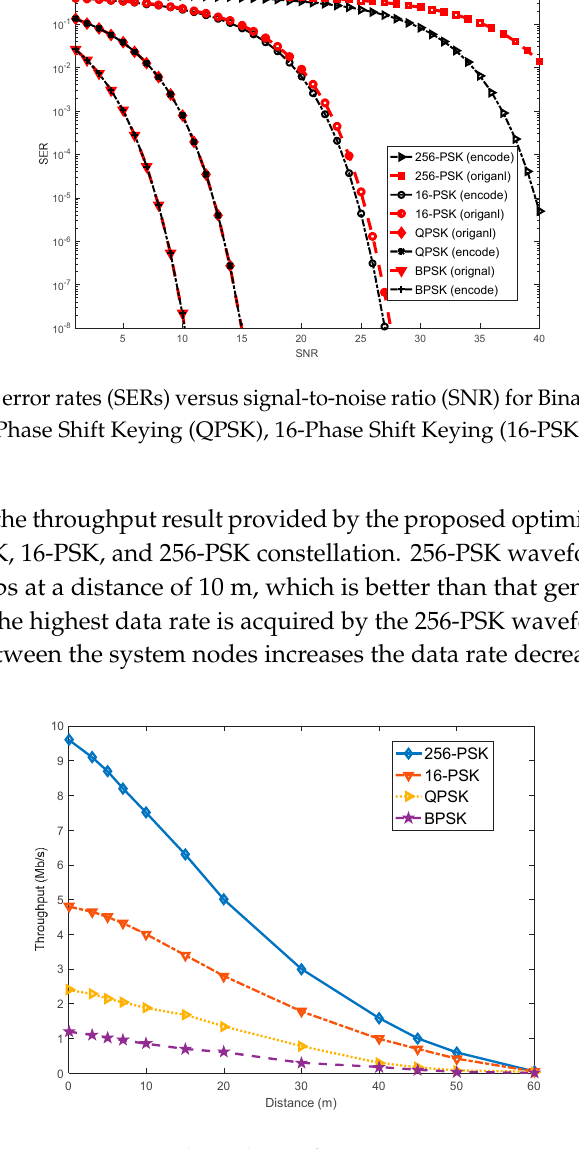
Figure 7. The symbol error rates (SERs) versus signal-to-noise ratio (SNR) for Binary Phase Shift Keying (BPSK), Quadrature Phase Shift Keying (QPSK), 16-Phase Shift Keying (16-PSK) and 256-Phase Shift Keying (256-PSK).